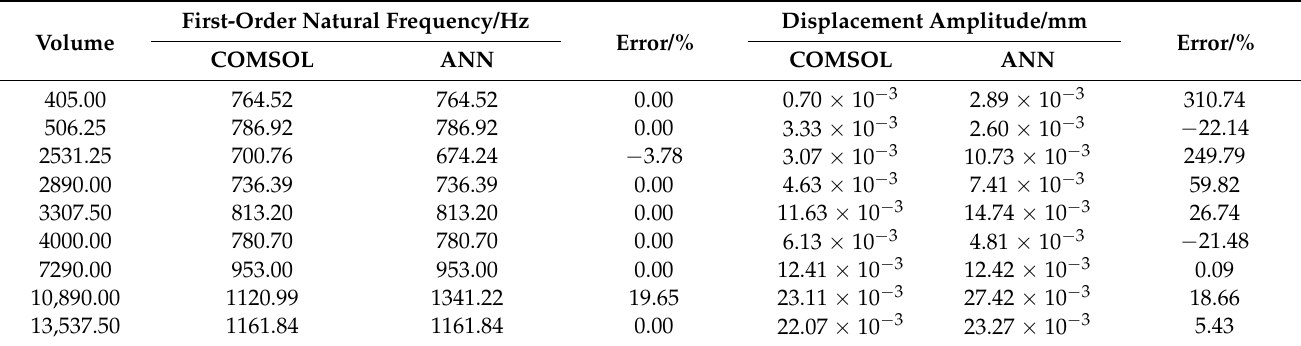
Table 6. The predictions and errors of the ANN model with a single input